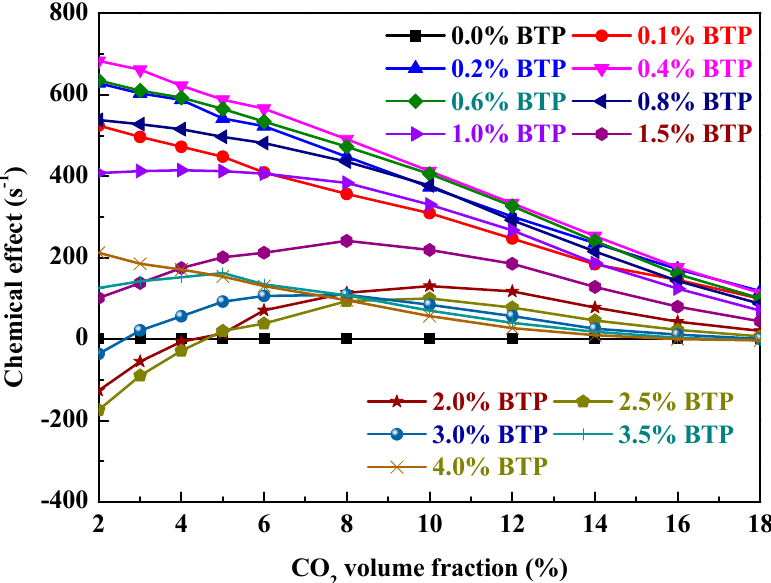
Figure 7. The dependence of chemical effect on CO 2 volume fraction with varying 2-BTP addition in Φ = 0.6 moist C 3 H 8 /air flames at 298 K and 1 bar.